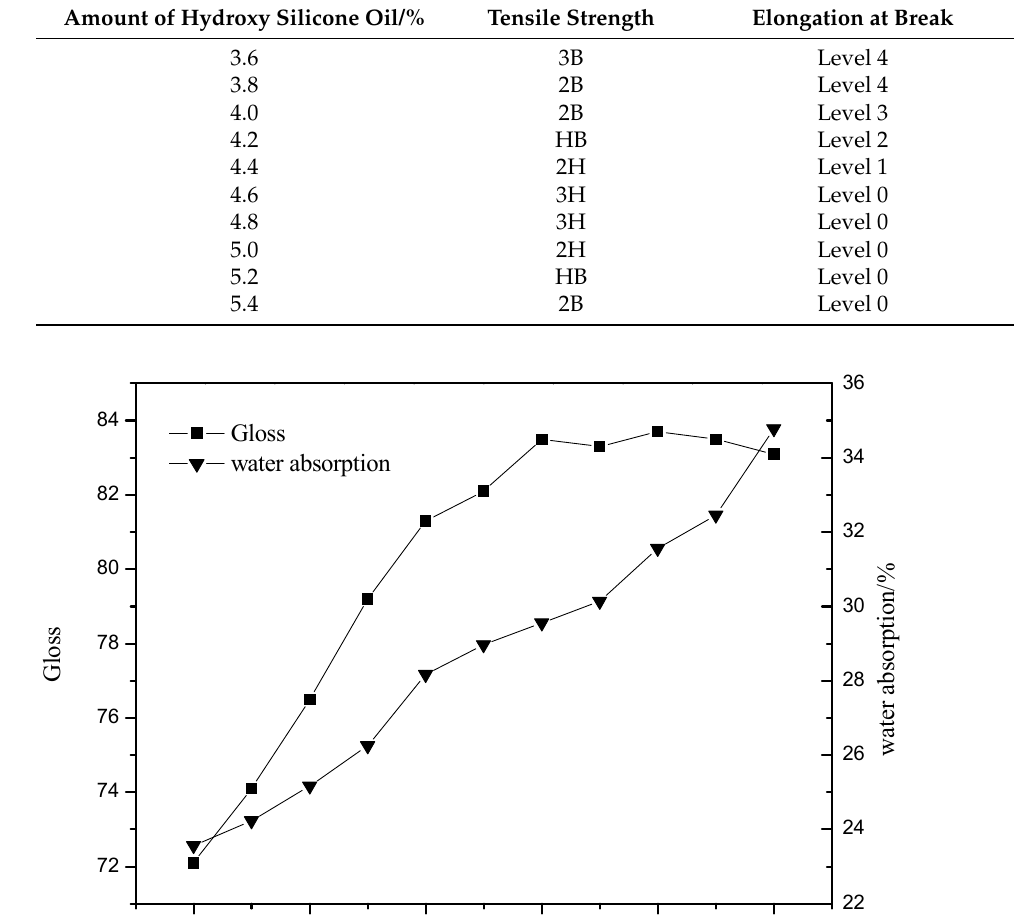
Table 1. Effect of the amount of hydroxy silicone oil on hardness and on adhesion.